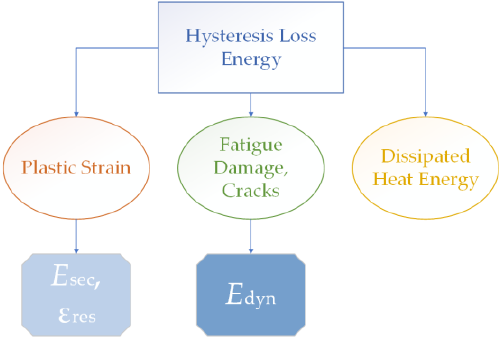
Figure 6. A schematic diagram of the processes composed by the mechanical hysteresis loop. Variations in the area of the mechanical hysteresis loops under cyclic loads are shown in Figure 7. At the beginning of the fatigue tests, the hysteresis loss for the neat PI was slightly higher than that for the neat PEI (60 and 50 kJ/m 3 , respectively). Both polymers were characterized by a gradual decrease in their loop area with an increase in the number of cycles. At the same time, the loss decreased to 40 kJ/m 3 for the neat PI, but it decreased only to 45 kJ/m 3 in the neat PEI case. For the PI/CF100 and the PEI/CF100 composites (according to Table 2), the S values were similar (~30 kJ/m 3 ) from the very beginning of the tests, and they remained almost unchanged until the tests were completed.